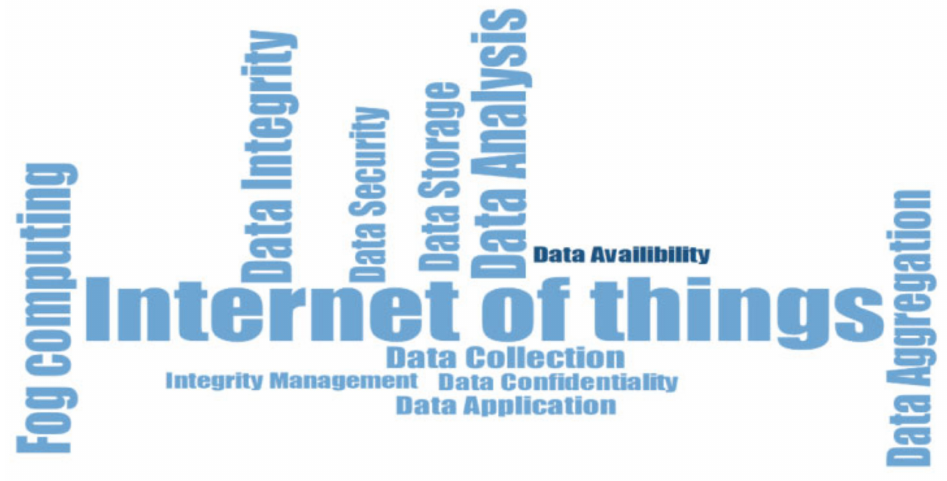
Figure 6. Codes Cloud are generated based on auto